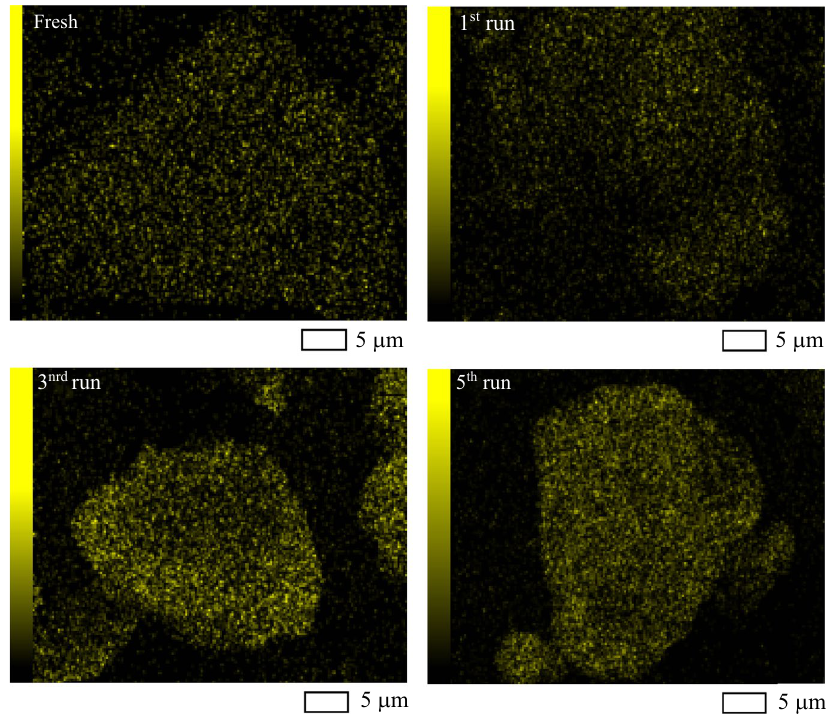
Figure 16. Representative Au mapping of Au 0.5 /TiO 2 photocatalyst after repetitive runs at loading of 1.0 g/L and light intensity of 3.20 mW/cm 2 in the presence of 20 vol% CH 3 OH as the hole